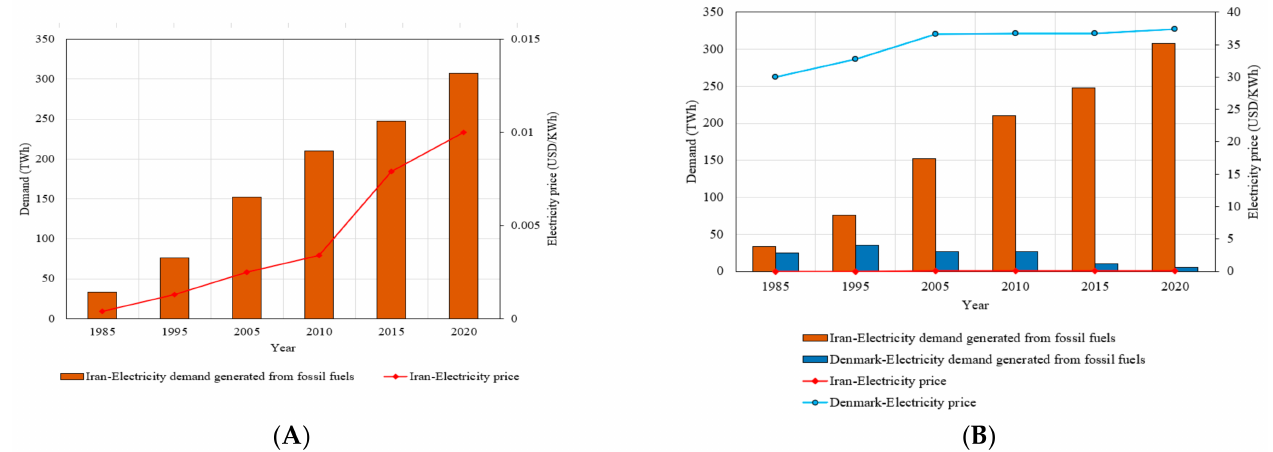
Figure 18. ( A ) Electricity demand vs. electricity price in Iran over the years ( B ) Comparison of electricity demand and price countries with